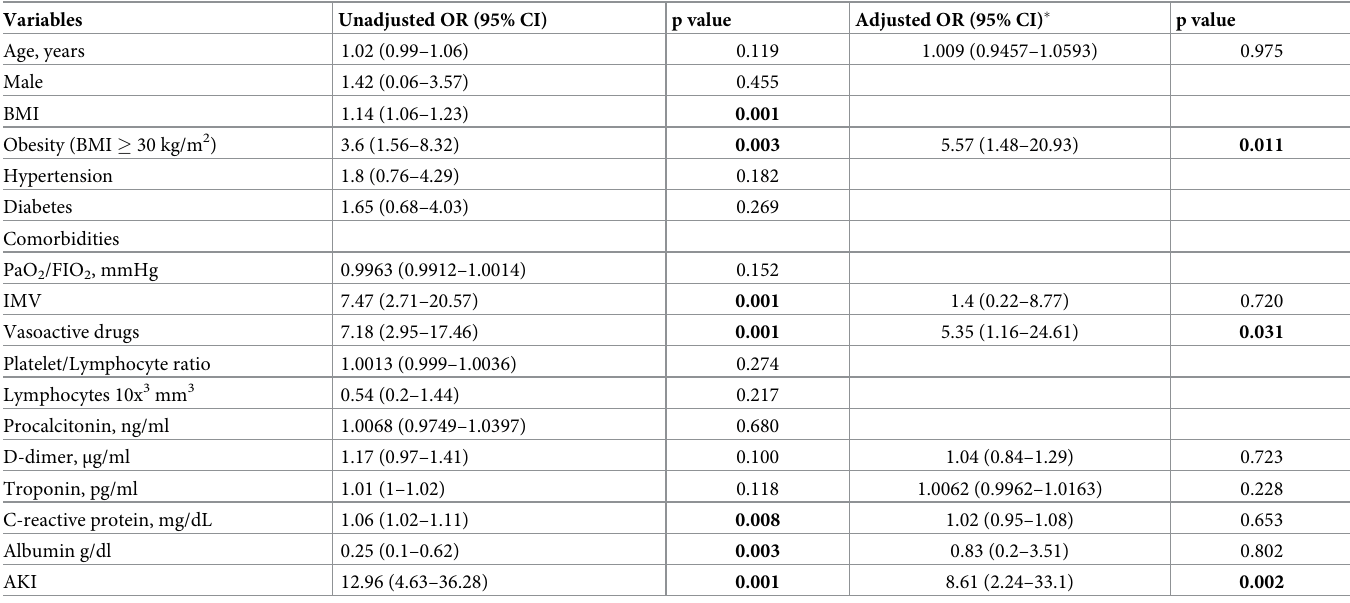
Table 4. Risk factors for